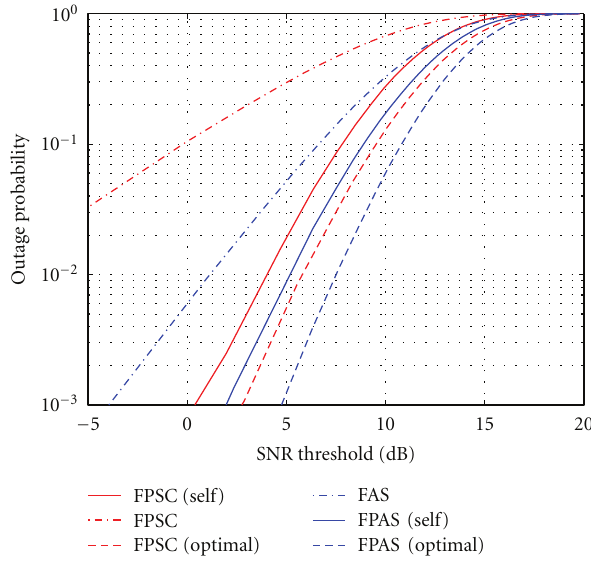
Figure 10: Parasitic selection combining (ULA): (5,1). Figure 11: Parasitic switching w/o antenna selection (ULA):